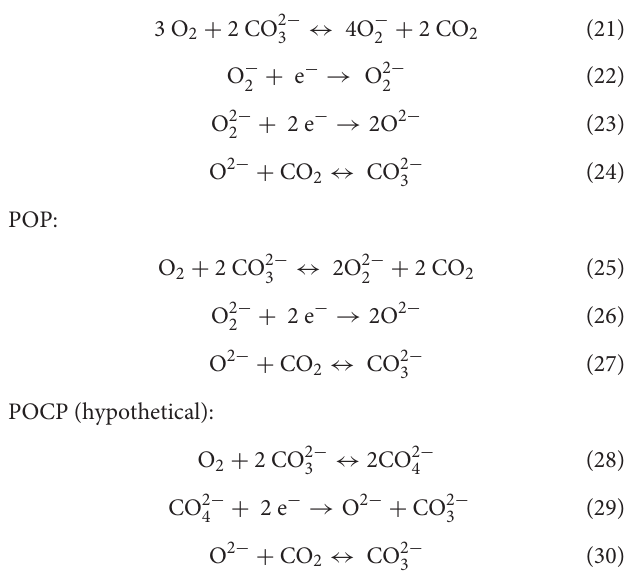
FIGURE 6 | Equivalent circuit describing MCFC operation, redrawn from Audasso et al.